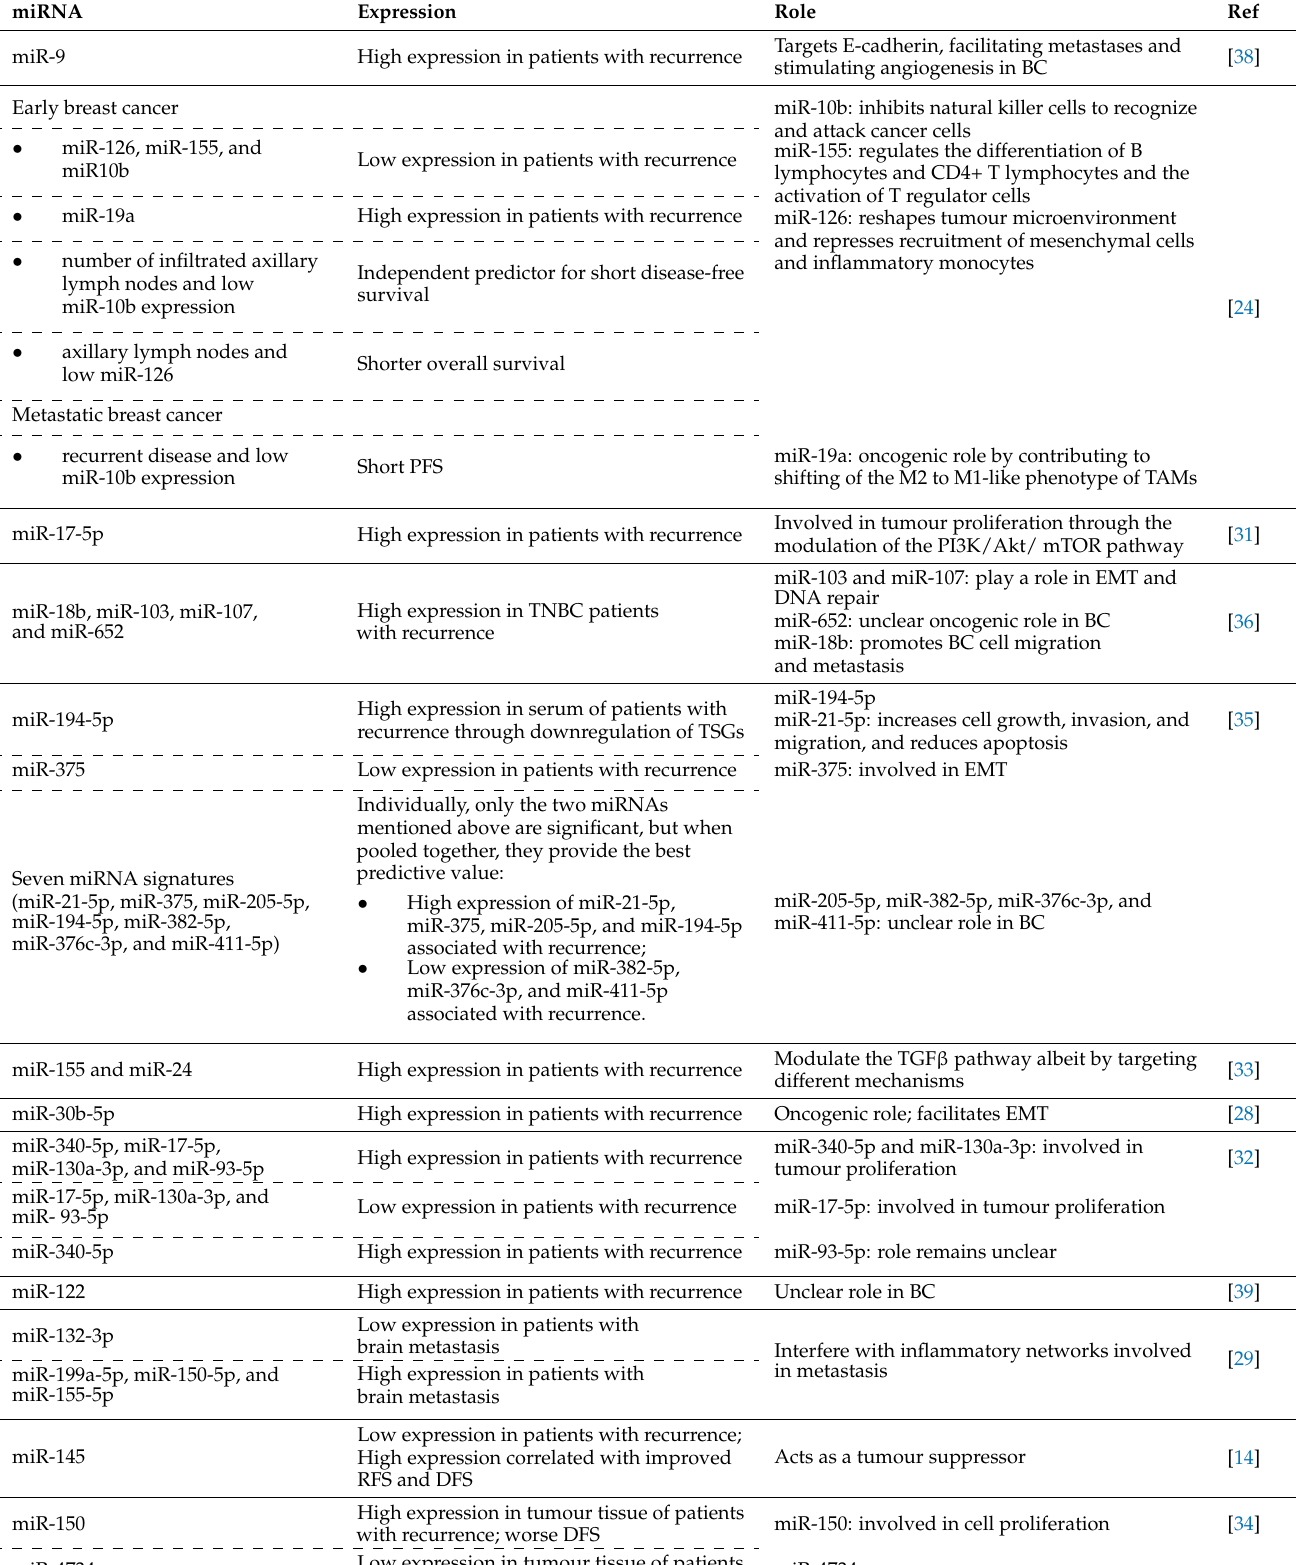
Table 3. MicroRNA expression patterns in recurrence and their functional